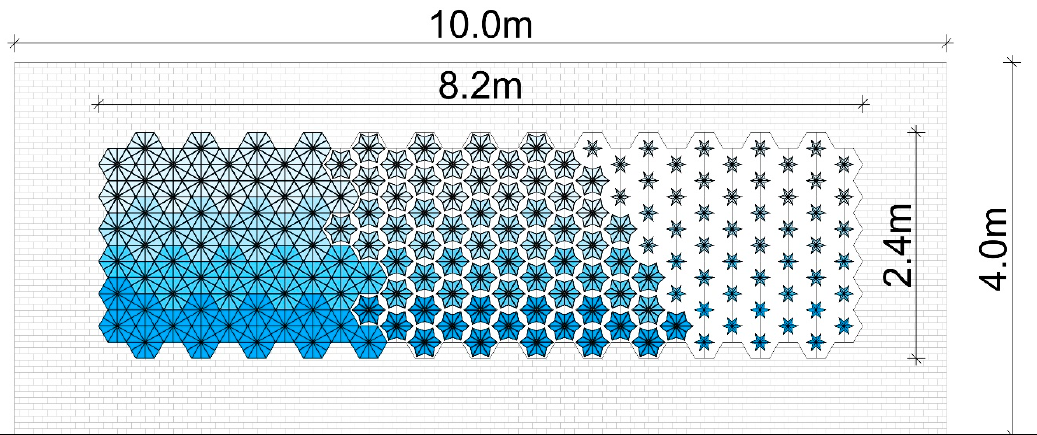
Figure 15. The pattern the Bio ‐ ABS module, with various changing configurations, when implemented on the reference building’s windows consisting of 188 modules; from left to right opening ratio increases and from bottom to top glazing opacity